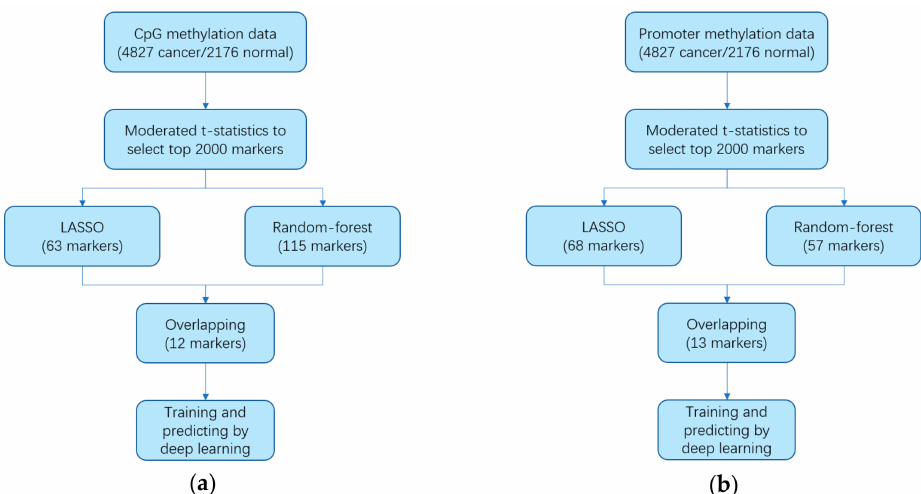
Figure 1. Workflow chart of identifying markers by machine learning. ( a ) Workflow of CpG methylation data. ( b ) Workflow of promoter methylation data. CpG methylation data contained 139,422